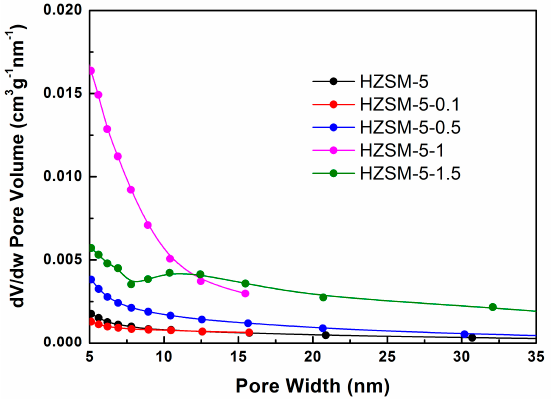
Figure 2. Pore size distribution of parent HZSM ‐ 5 and the hierarchical HZSM ‐ 5 treated with different concentrations of NaOH solution (0.1–1.5 M) at 343 K for 1 h.